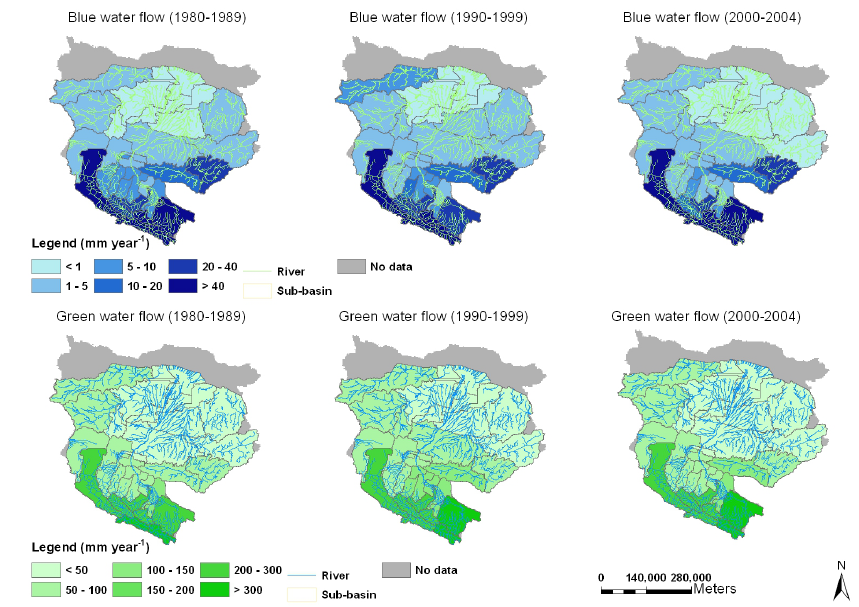
Fig. 5. The green/blue water flows (the best simulation and long term average annual values) per unit area (mmyr − 1 ) from the 1980s to the 2000s in the Heihe river